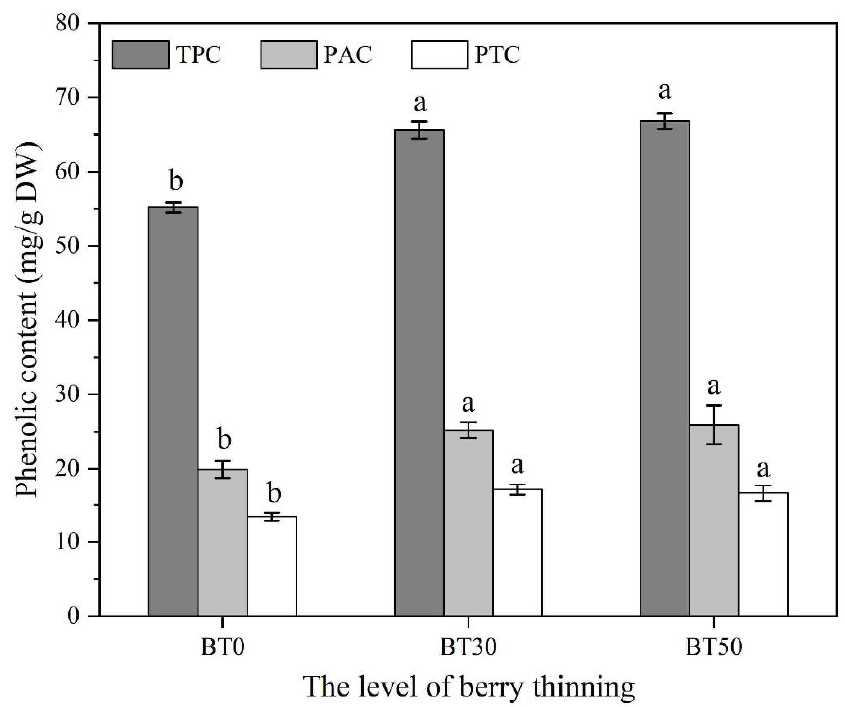
Figure 4. Effects of berry thinning on the composition and concentration of phenolic compounds in Shine Muscat grape skins. Different letters on the bars with the same color indicate statistically significant differences at p < 0.05. TPC, total phenolic concentration expressed in mg gallic acid/g dry weight; PAC, proanthocyanidin concentration expressed in mg catechin/g dry weight; PTC, polymeric tannin concentration expressed in mg tannic acid/g dry weight.